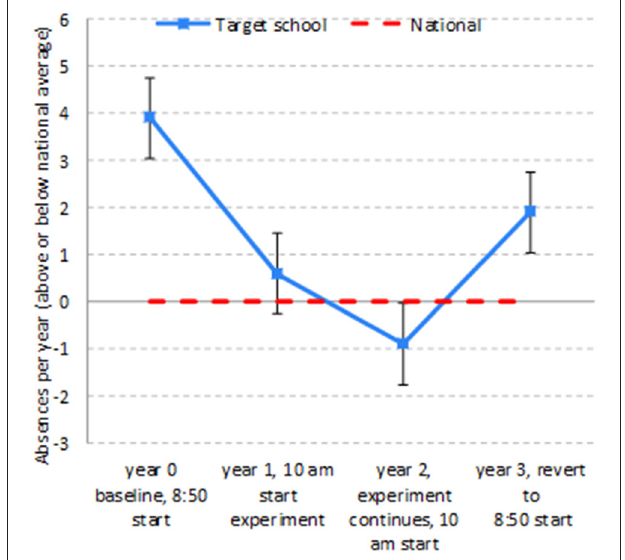
FIGURE 1 | Absences due to illness, differences from national